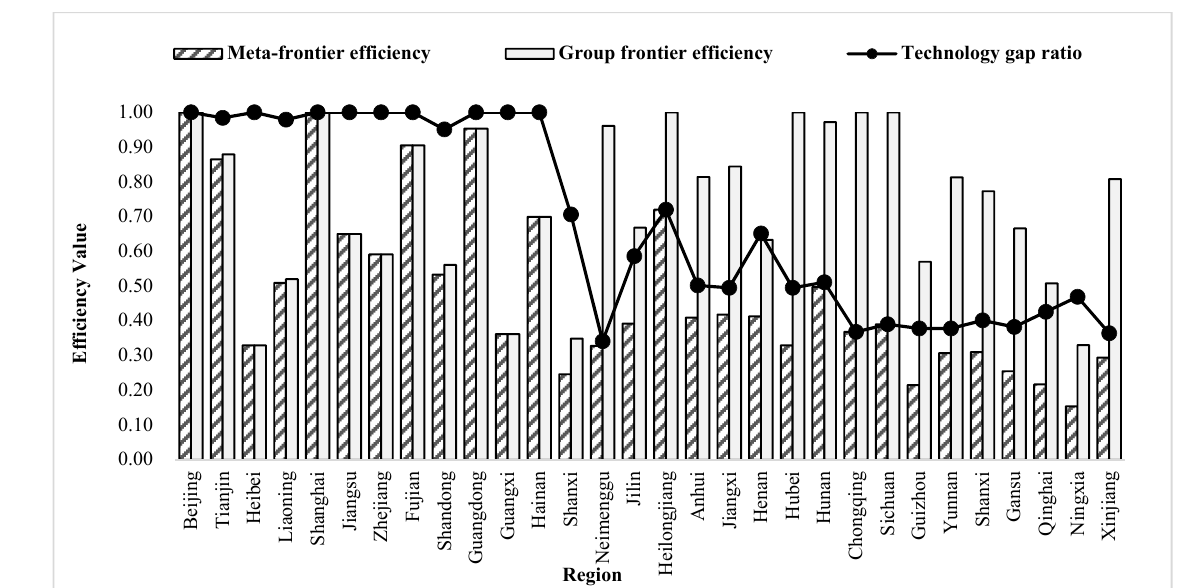
Figure 3. Green development efficiency under the group frontier of east, central, and west China.